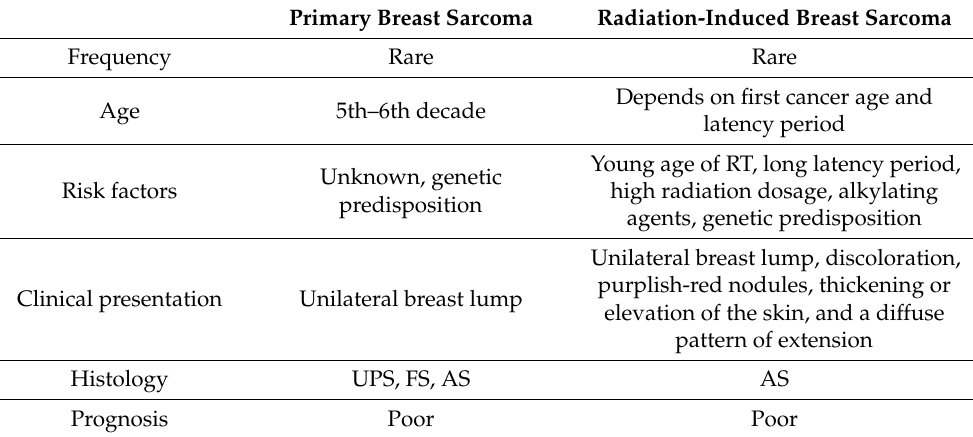
Table 1. Clinicopathological differences between primary and radiation-induced breast sarcoma. Primary Breast Sarcoma Radiation-Induced Breast Sarcoma Frequency Rare Rare Depends on first cancer age and Age 5th–6th decade Young age of RT, long latency period, Unknown, genetic Risk factors high radiation dosage, alkylating predisposition agents, genetic predisposition Unilateral breast lump, discoloration, purplish-red nodules, thickening or Clinical presentation Unilateral breast lump elevation of the skin, and a diffuse pattern of extension Histology UPS, FS, AS AS Prognosis